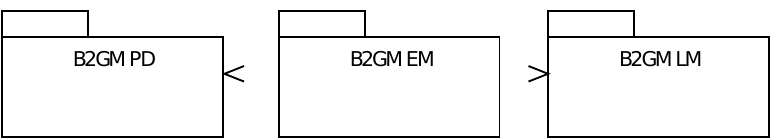
Figure 10. GIS DB conceptual model. Table 4. B2GM package requirements.